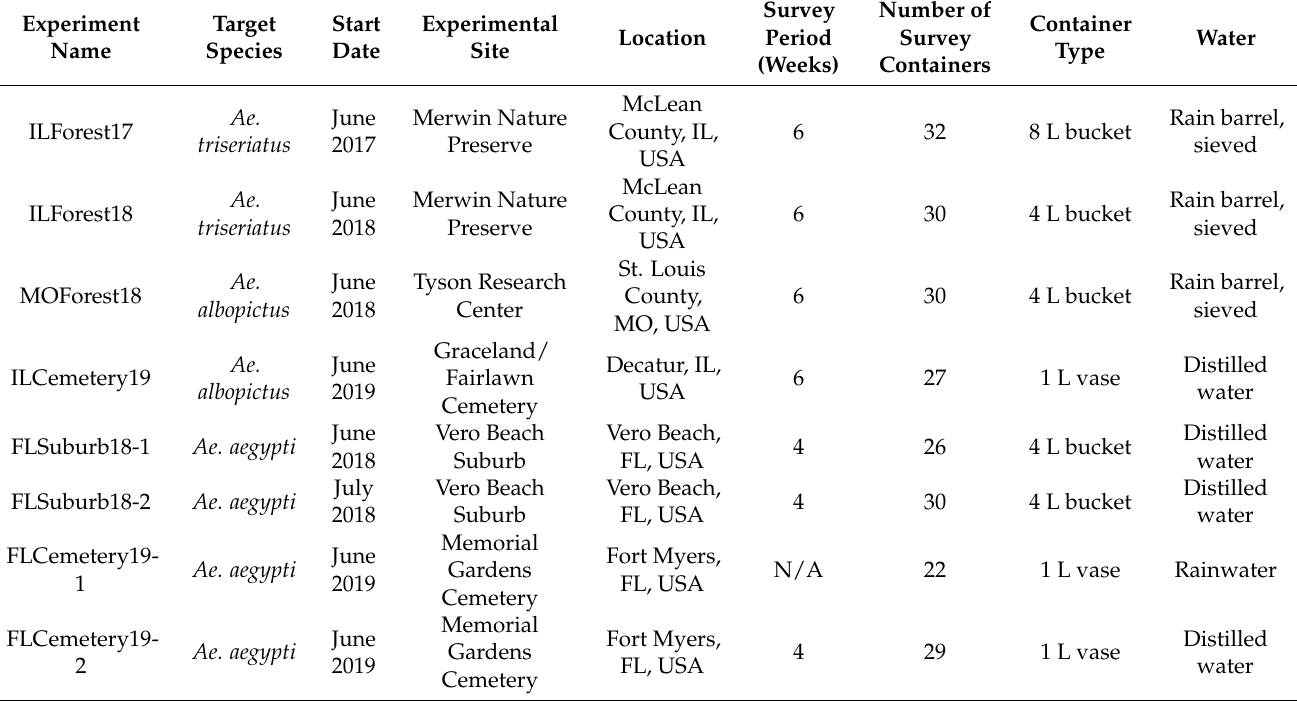
Table 1. Methods for experiment sampling periods. The variations in procedures between experi- ments for the survey period are outlined above. The experiments are grouped by the target species. 1 L vases are cemetery vases fixed to the ground by a stake. Rain barrel water was collected from barrels on-site and sieved to remove larvae, predators, and parasites. N/A = not applicable, because we sampled established cemetery